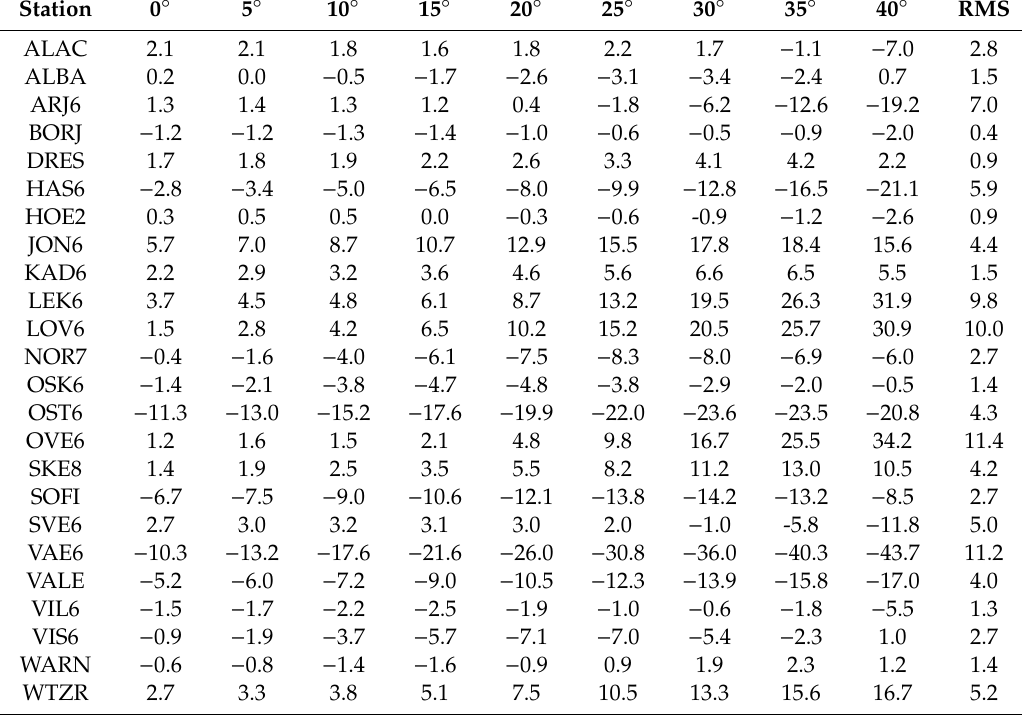
Table A5. Biases in height between solutions sol_i_x and sol_t_xx, where xx is the applied mask. Values are in